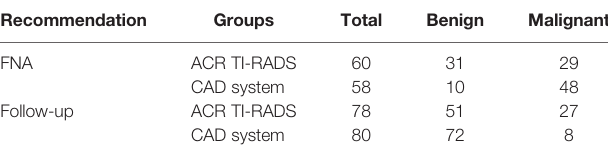
TABLE 3 | FNA recommendation by expert (using TI-RADS) and CAD system.